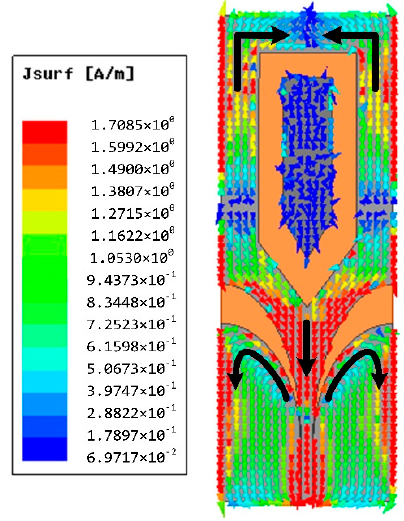
Figure 5. The surface current distribution of Ant-3 at 0.97 GHz.